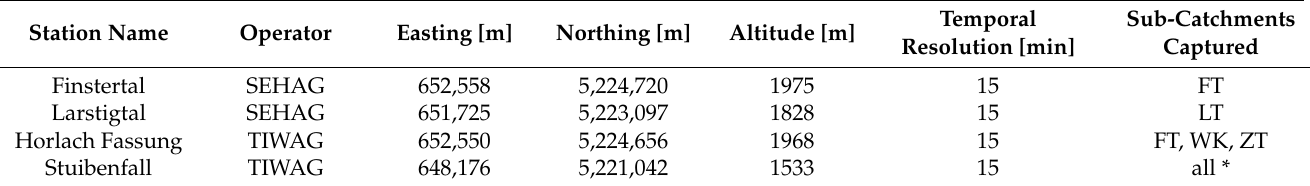
Table 4. Site parameters of the hydrological gauges used within this